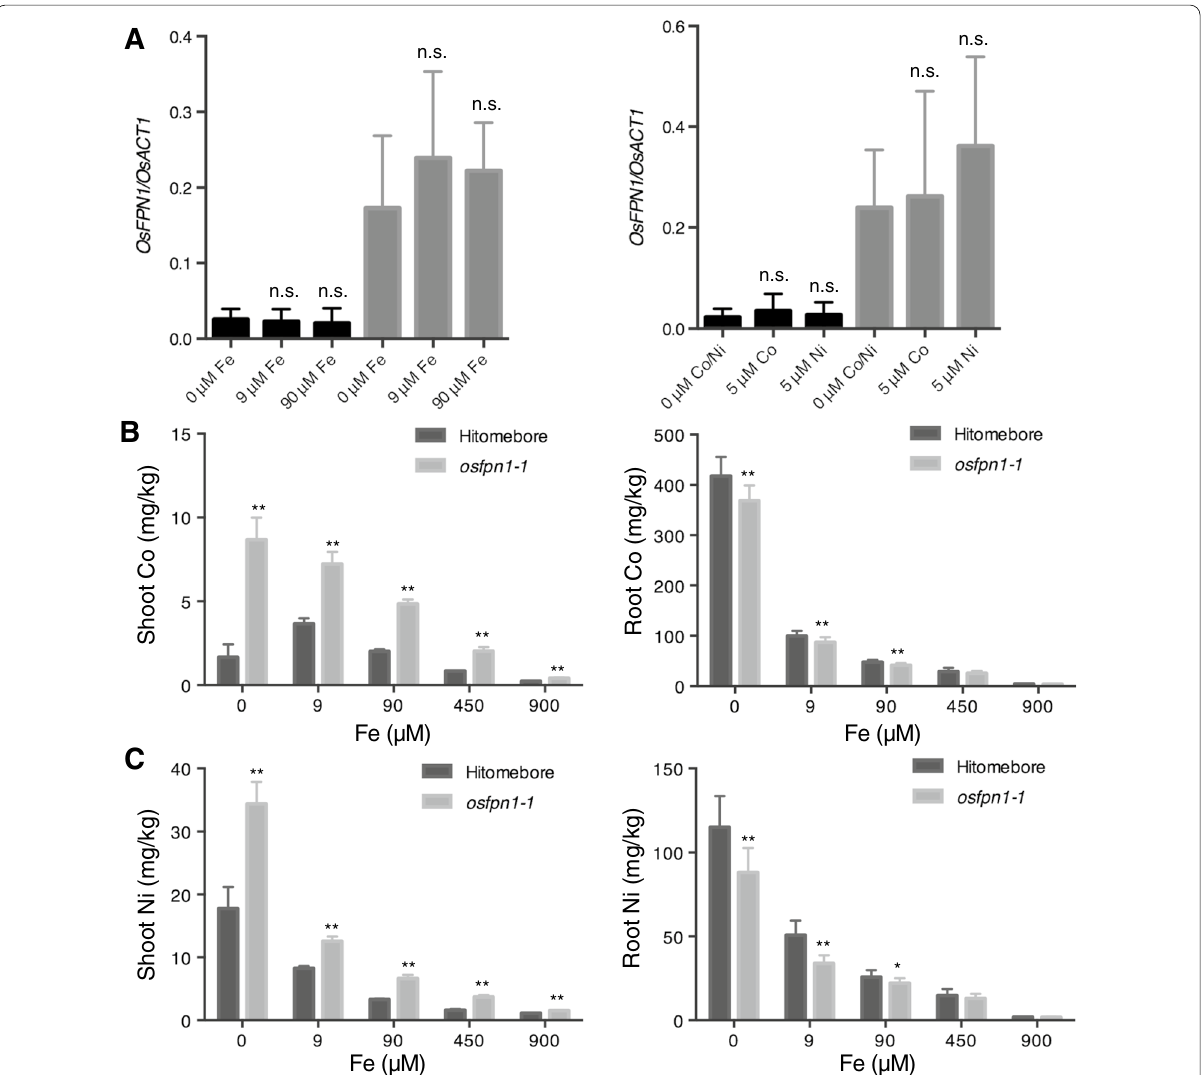
Fig. 7 Effect of Fe on Co and Ni accumulation. A OsFPN1 expression levels in the shoots (black) or roots (gray) of 10-d-old seedlings under 0, 9, and 90-µM Fe-citrate conditions or 0 and 5-µM Co or Ni conditions (n 4). OsACT1 is OsActin1. Dunnett’s test (compared to 0 µM Fe or 0 µM Co/Ni in the = shoot or root). n.s., p 0.05. Tukey’s multiple-comparison tests were conducted among the same tissue, p < 0.05. Co ( B ) and Ni ( C ) concentrations ≥ in the shoots (left panel) and roots (right panel) of 21-d-old seedlings. The x-axis represents the Fe concentration (µM). Plants were grown in a hydroponic culture. Data represent the mean SD (n 8–10). Student’s t -test (compared to Hitomebore). *p < 0.05; ** p < ± =